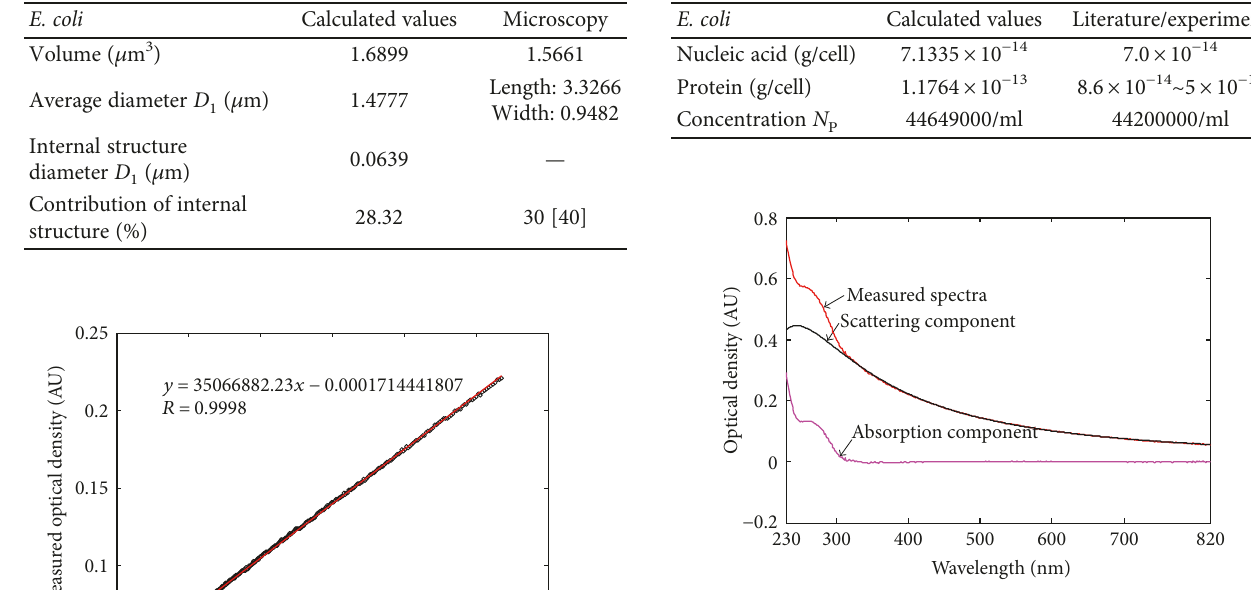
Table 2: The calculated values by absorption component of E. coli